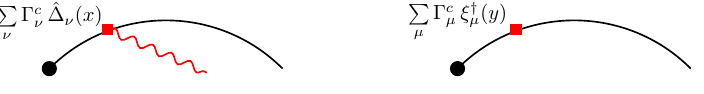
Figure 3 . Sequential propagators for the photon exchange diagram using the summed- (cid:22) -insertion. The calculation of the diagrams in (cid:12)gure 1 requires a total of 5 inversions per quark (cid:13)avour and source position with the summed- (cid:22) insertion, 1 for the point-to-all propagator, 1 + 1 for the two sequential propagators (2.39) and (2.40), 1 additional inversion for